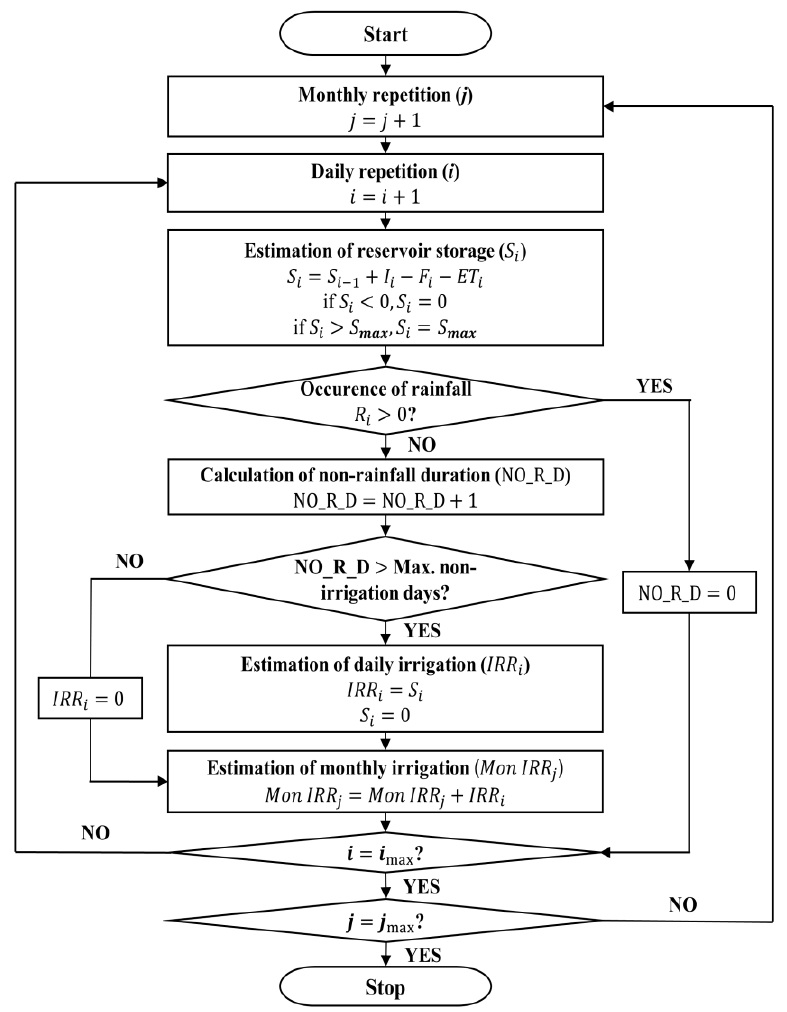
Figure 2. Flowchart for simulating the irrigation from the mool-tong on Jeju Island.